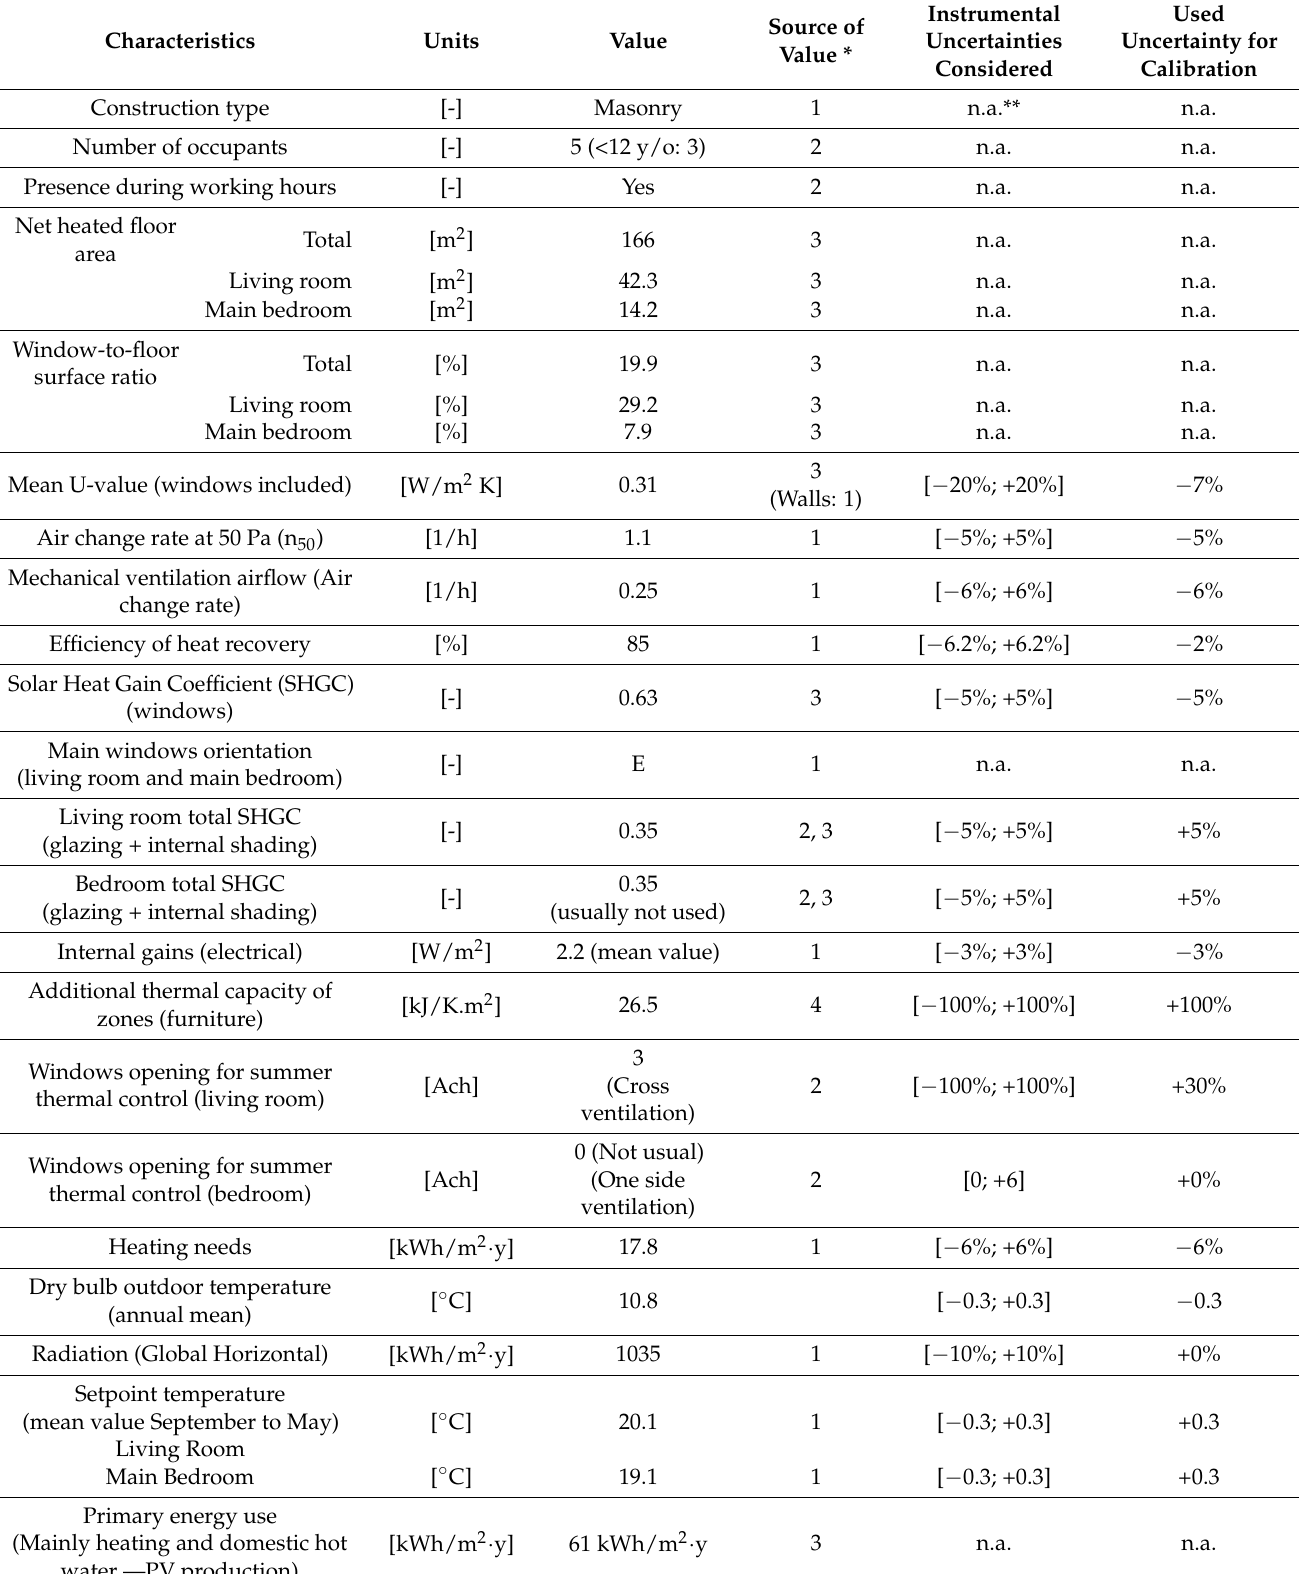
Table 1. Characteristics of the calibrated thermal